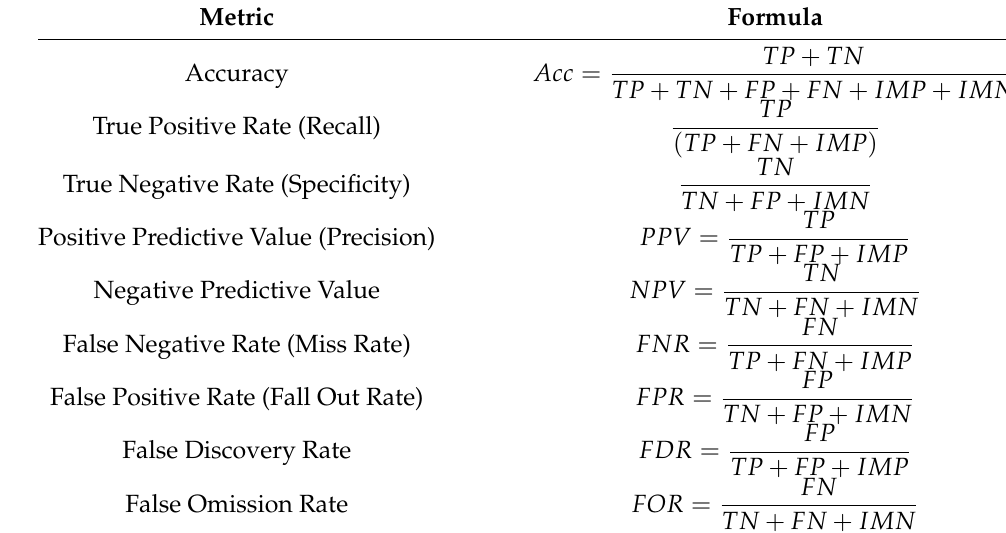
Table 5. Performance metrics of reduced confusion